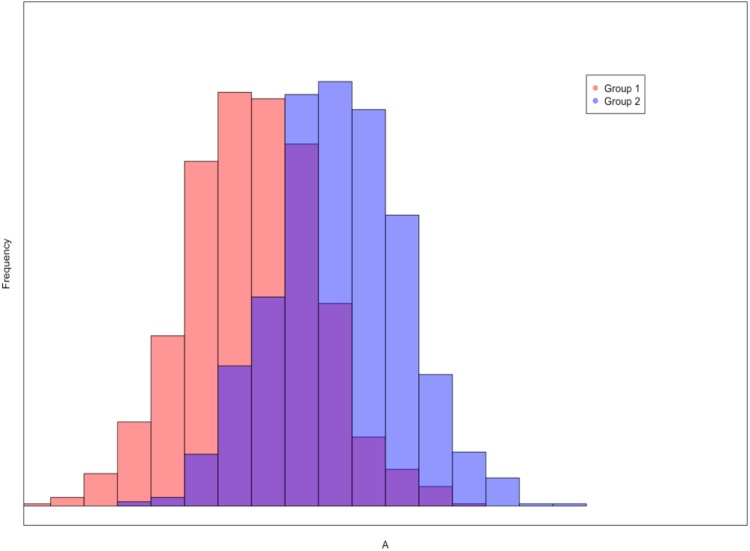
An example of an overlapping histogram seen by the participants.The red distribution represents the frequency of scores from Group 1, the blue distribution represents the frequency of scores from Group 2, and the purple coloring indicates where the distributions overlap. In this example Cohen’s d = 1.3.